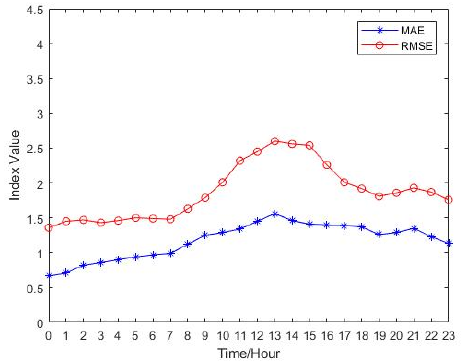
Figure 6. Two indicators evaluated on one day’s test data set.